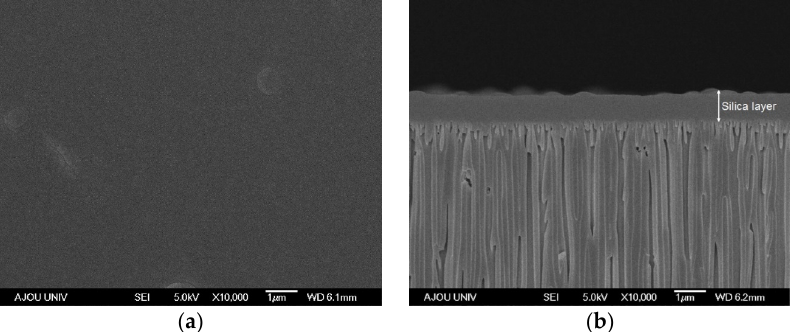
Figure 3. SEM photos of the silica layer on the porous alumina substrate: ( a ) top view and ( b ) cross ‐ sectional view.